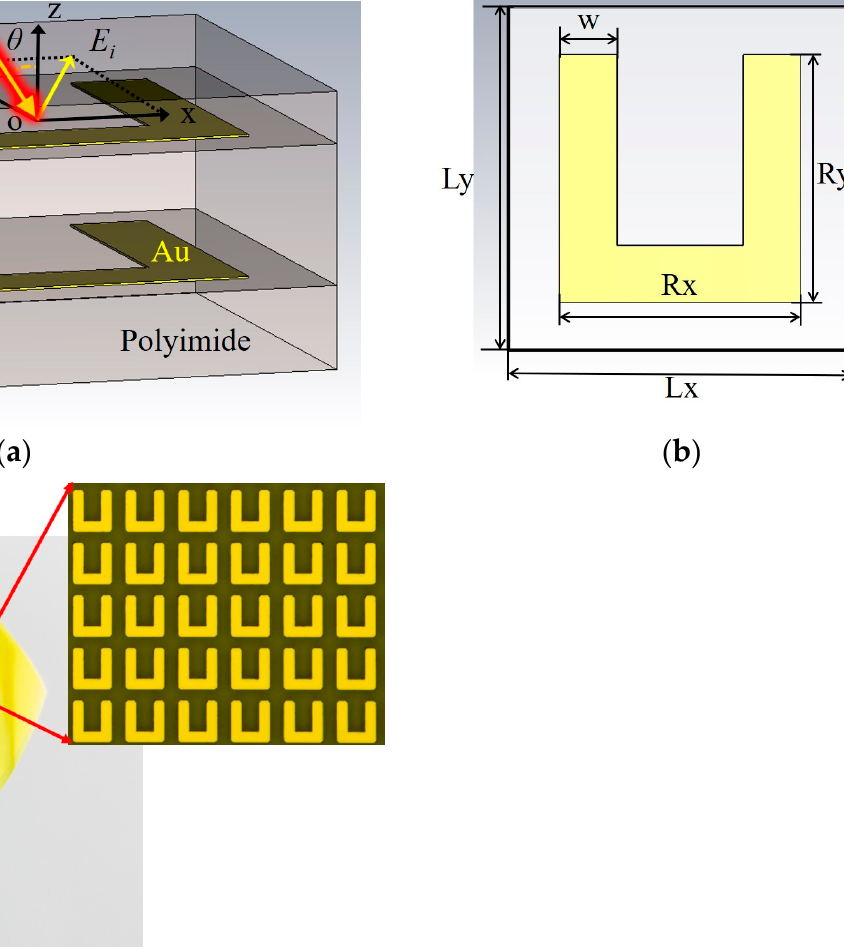
relative to the air layer, the phase shift of which was set to 0 ◦ [43]. The air layer’s thickness was 26.5 µ m, which was the same as the QWP’s thickness. As shown in Figure 1a, the incidence angle θ is the angle between the incident direction of the terahertz wave and the -z-axis in the xoz-plane. The transmission coefficients ( t x , t y ), phases ( ϕ x , ϕ y ), and phase difference ( ∆ ϕ = ϕ x − ϕ y ) of the incident wave in both the x- and y-directions were obtained by simulation when the incidence angle was 0 ◦ , as shown by the solid lines in Figure 2. The dotted, solid lines in Figure 2 are the corresponding data obtained from the terahertz time-domain spectroscopy experiments. It can be seen that the simulation and experimental results are in good agreement. In the range of 1.62~1.88 THz, the